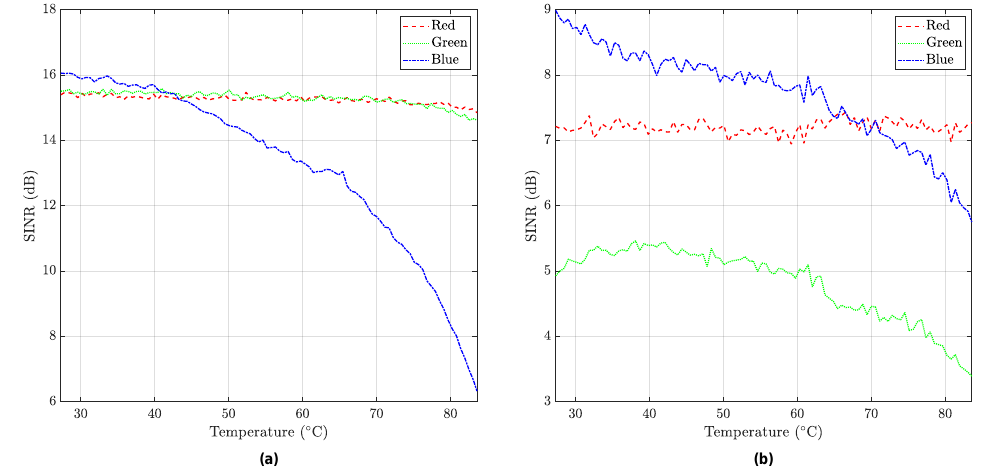
Figure 11. SINR at different temperatures, compensating the channel using the CSI corresponding to 27°C and with a medium SNR value (20 dB). ( a ) Sony IMX249 and ( b ) Foveon X3. Dashed line, dotted line, and dash-dot line correspond to red, green, and blue, respectively.